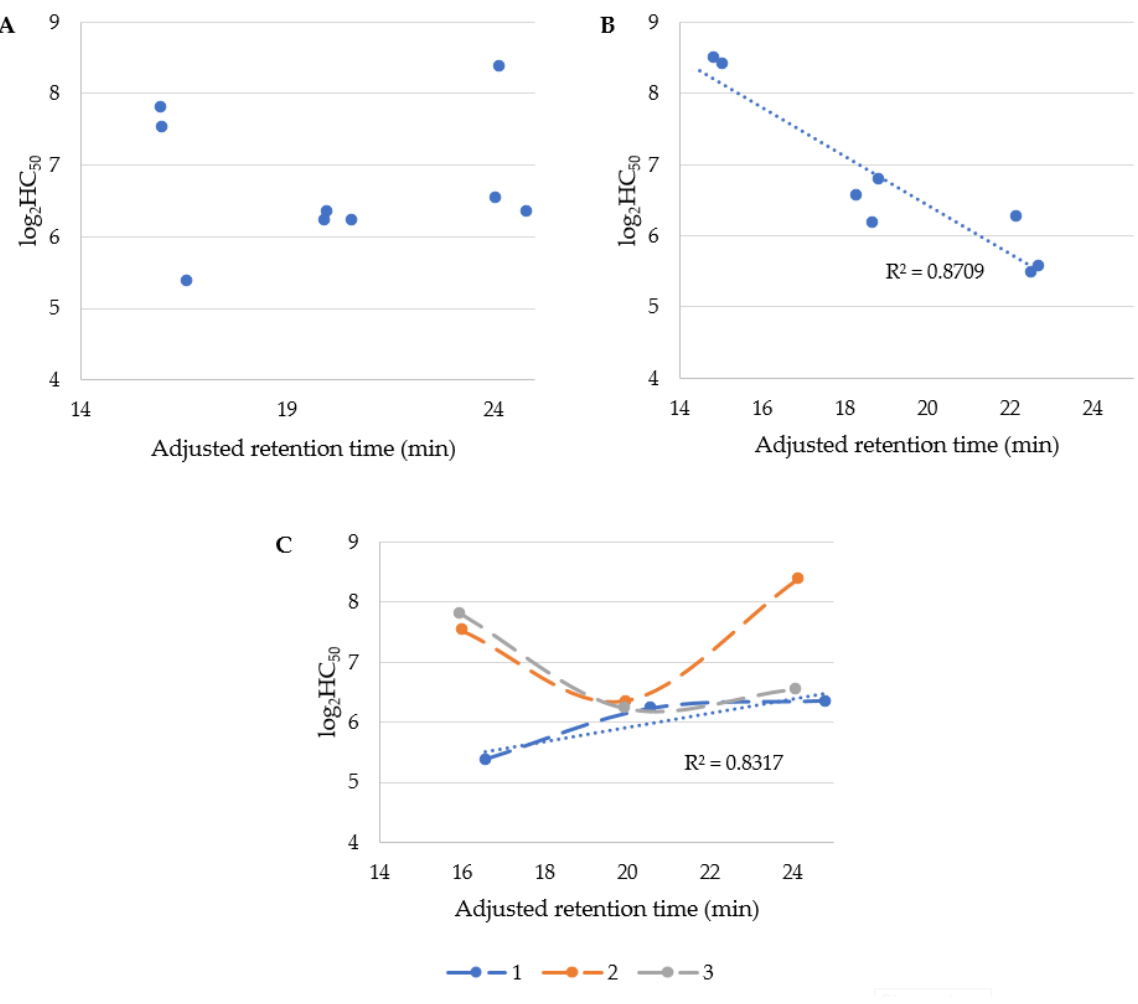
Figure 2. Adjusted retention time vs. log 2 HC 50 of ( A ) USCLs and ( B ) gUSLCs, and ( C ) USCLs differentiated into three series depend on serine position.